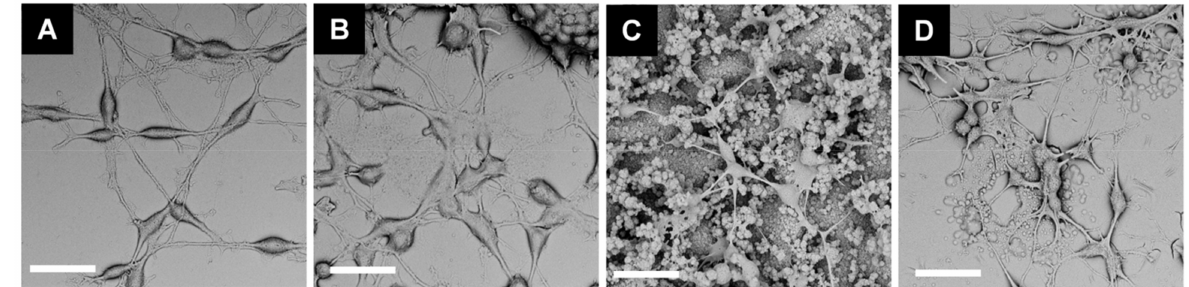
Figure 6. Morphology of B35 cells cultured on PEDOT matrices. SEM micrographs of B35 cells fixed after 48 h cultured on the surfaces of ( A ) platinum, ( B ) PEDOT/PSS, ( C ) PEDOT/PF 6 , and ( D ) PEDOT/ClO 4 . The scale bar represents 30 µ